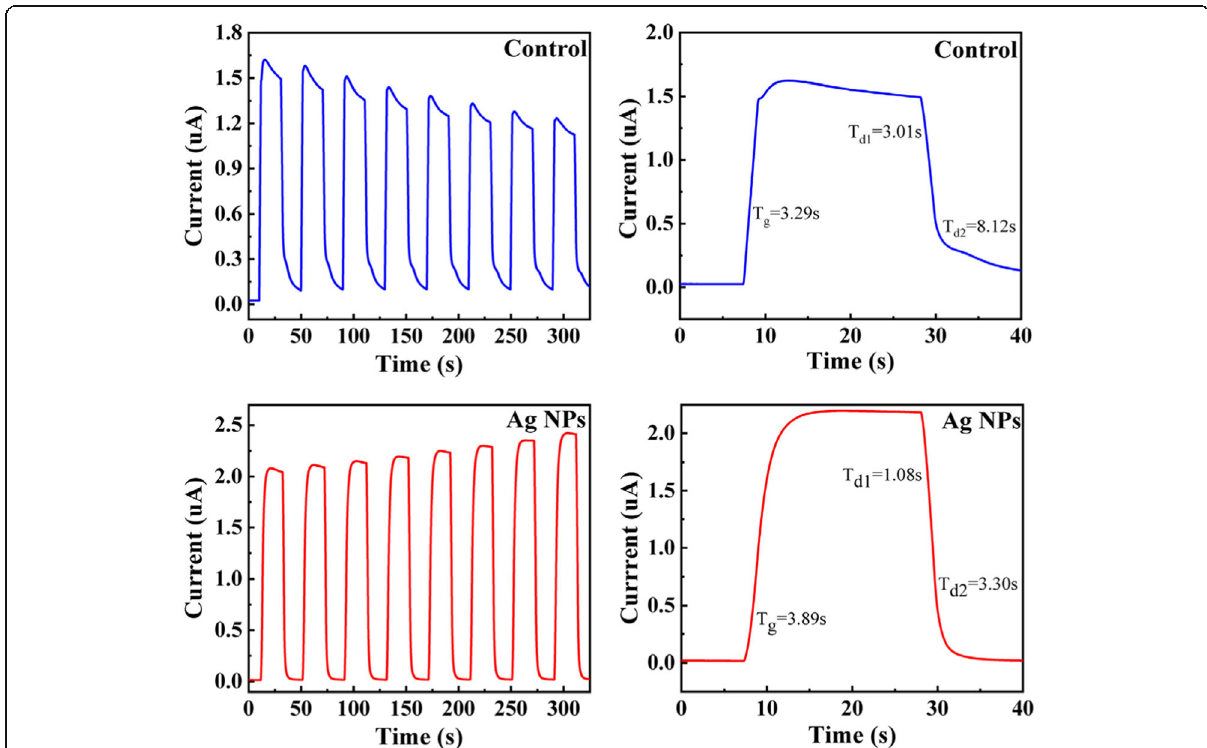
Fig. 6 a Time-dependent photocurrent of ZnO film without Ag NPs with 365 nm illumination at 20 V. b Response of ZnO film without Ag NP photodetector. c Time-dependent photocurrent of ZnO film with Ag NPs with 365 nm illumination at 20 V. d Response of ZnO film with Ag NP photodetector. Liu et al.